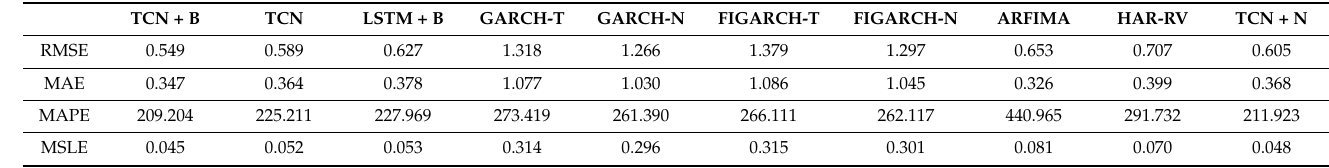
Table 14. The error comparison between the TCN model with attention factor based on the RV correlation coefficient and other models. GARCH-N FIGARCH-T FIGARCH-N ARFIMA HAR-RV TCN +